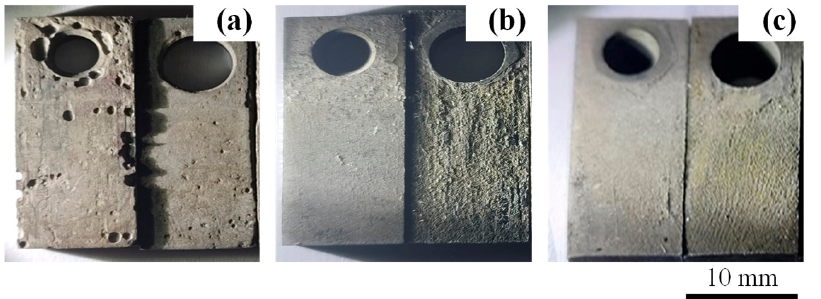
Figure 6. Specimen appearance (N80/1Cr from left to right) under three conditions: ( a ) 50 °C-CO 2 : 0.30 MPa; ( b ) 100 °C-CO 2 : 0.63 MPa; ( c ) 114 °C-CO 2 : 0.73 MPa; after removal of product fi lm.